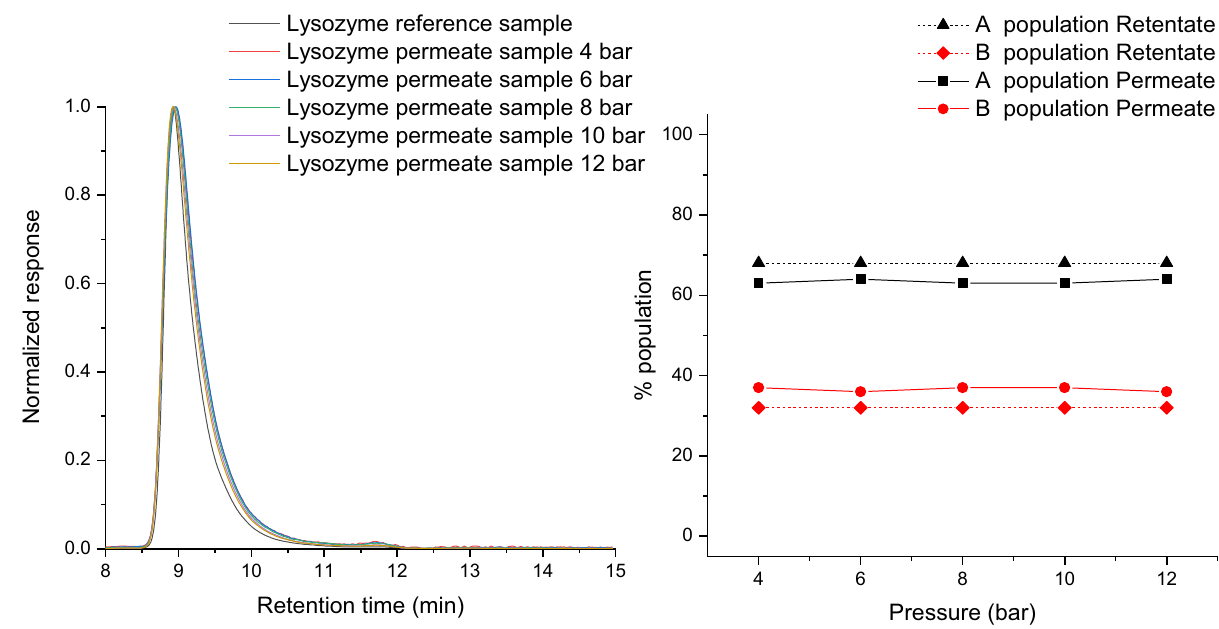
Figure 2. Normalized chromatograms of permeate samples (left) and population distribution (right) for M1 membrane.